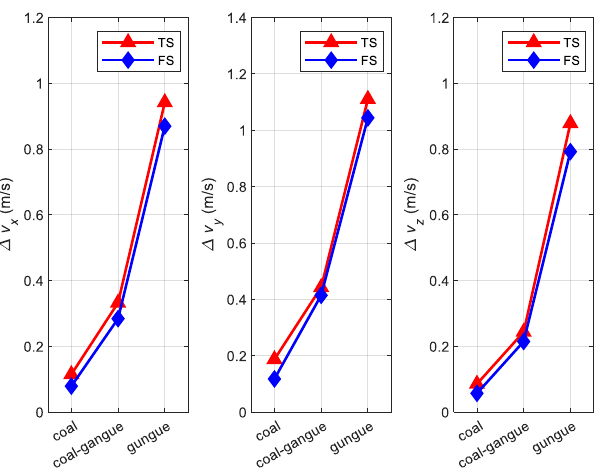
Figure 11. The sculling error statistics using three-subsample (TS) compensation algorithm and four-subsample (FS) compensation algorithm under different coal and rock characteristics. Figure 10 is the coning error statistics using the three-subsample (TS) compensation algorithm and four-subsample (FS) compensation algorithm under different coal and rock characteristics. Figure 11 is the sculling error statistics using the three-subsample